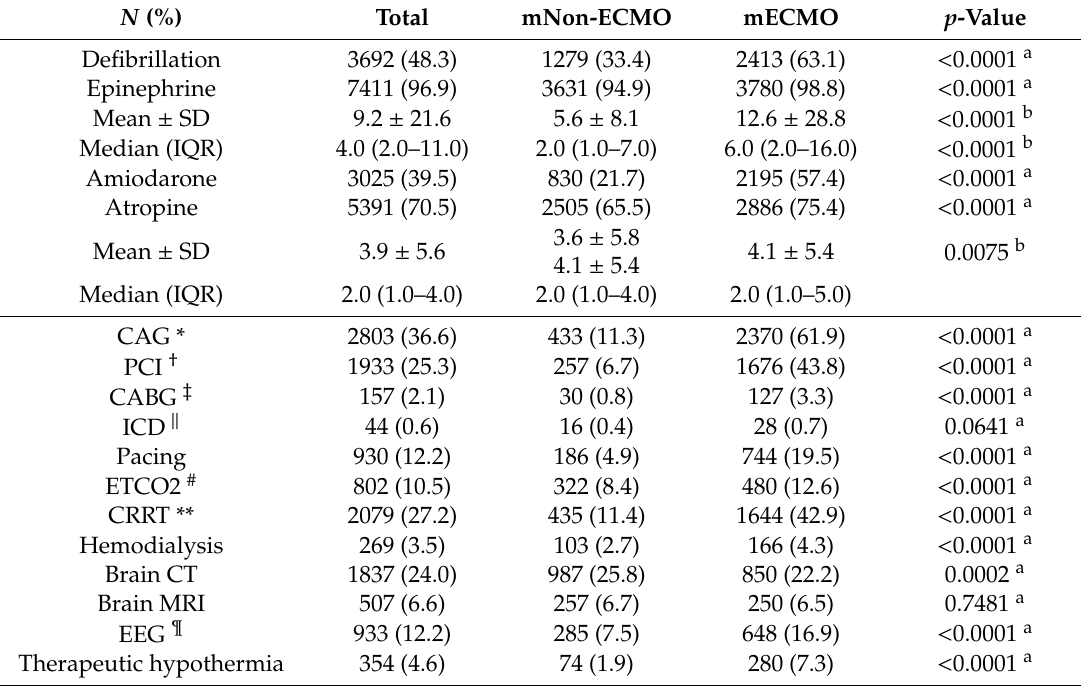
Table 3. Medications and procedures in the patients with arrest after propensity score matching. N